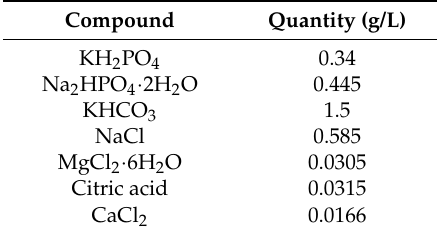
Table 1. Chemical composition of the artificial